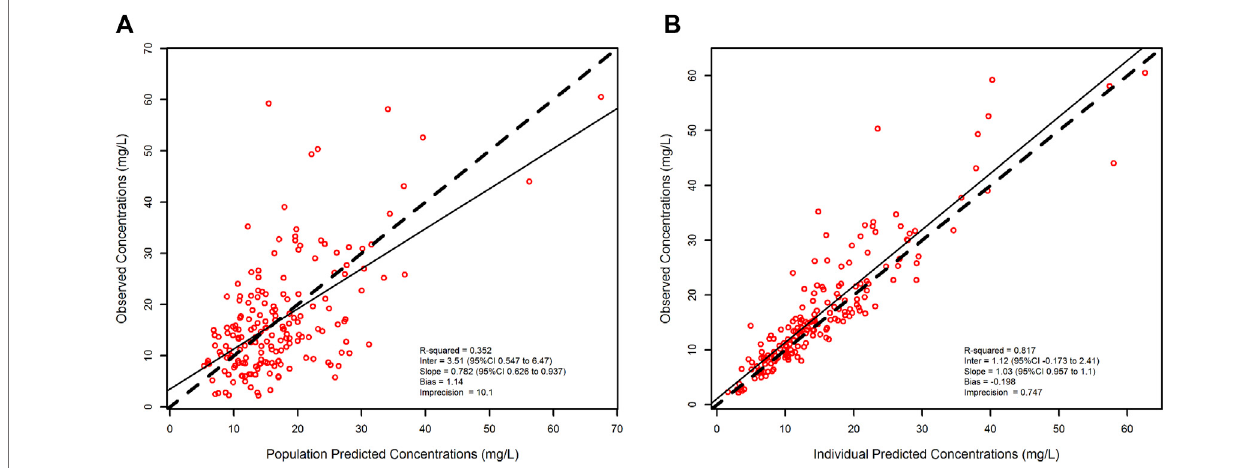
FIGURE3| Scatterand linear fi tplotforthe fi nalpopulation pharmacokineticmodel. Observedversuspopulation-predictedplasmaconcentrations(left panel) and observed versus individual-predicted plasma concentrations (right panel).